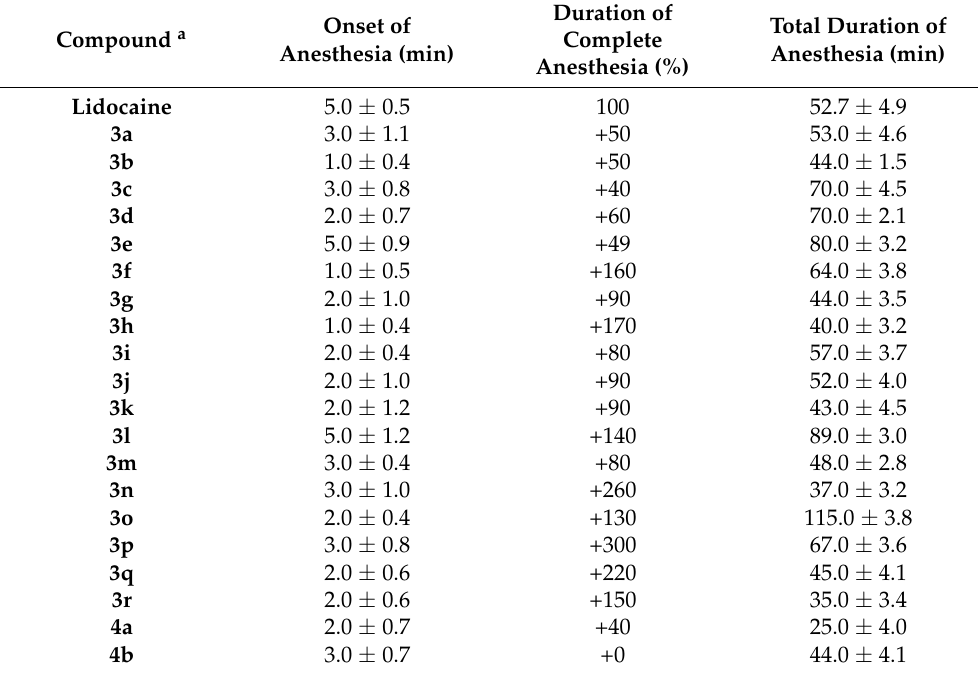
Table 4. Local anesthetic activity of the studied compounds in rabbit corneal model in compared to